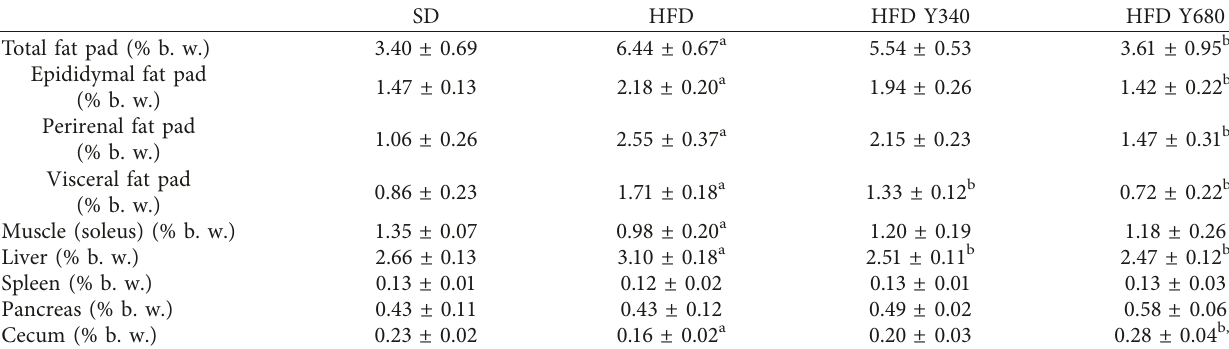
Table 3: Effects of yacon supplement on organs weights of HFD-fed